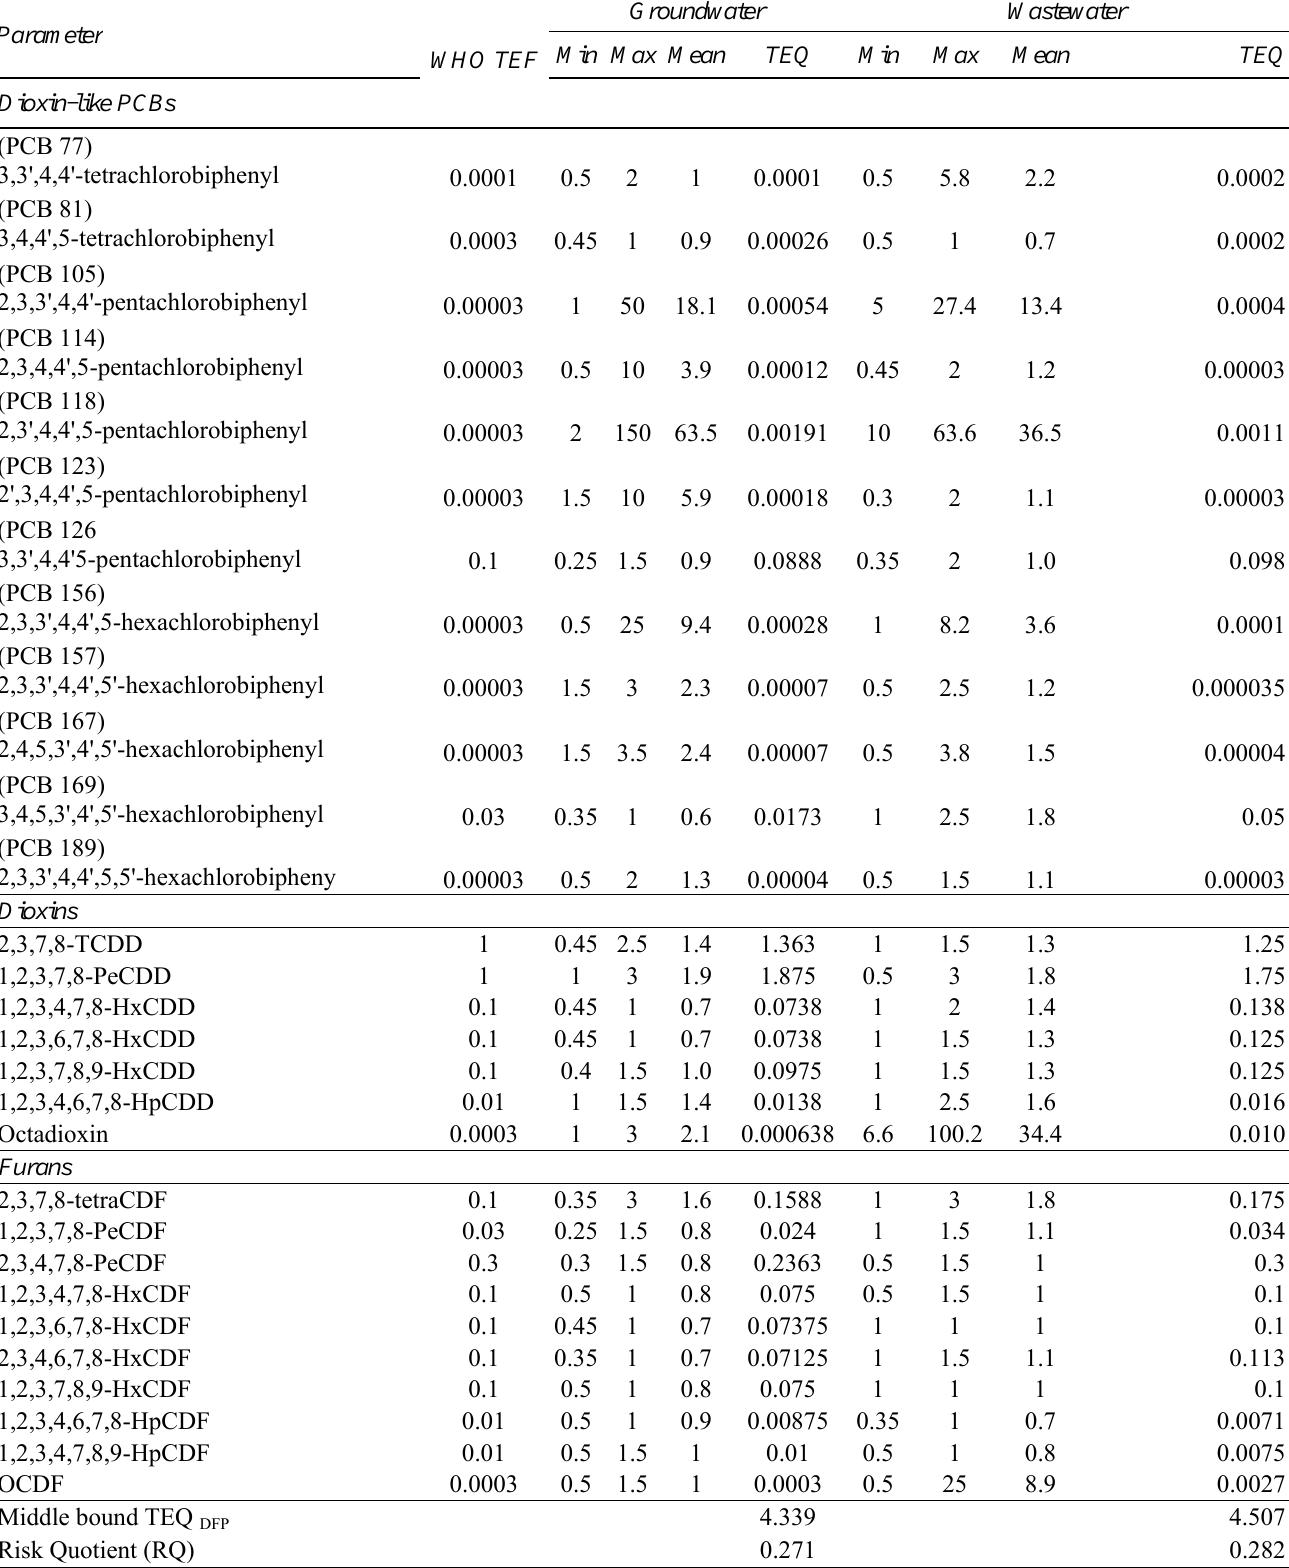
Table 4: Minimum, maximum, and mean of the pooled grab wastewater and groundwater samples in pg/L and percent contribution to total TEQ (middle bound) using the mean concentration Groundwater Wastewater Parameter Min Max Mean TEQ WHO TEF